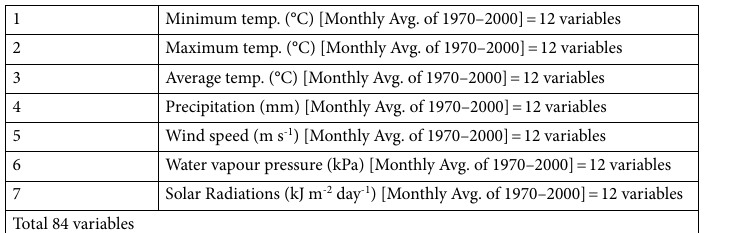
Table 3. Mean monthly environmental variables